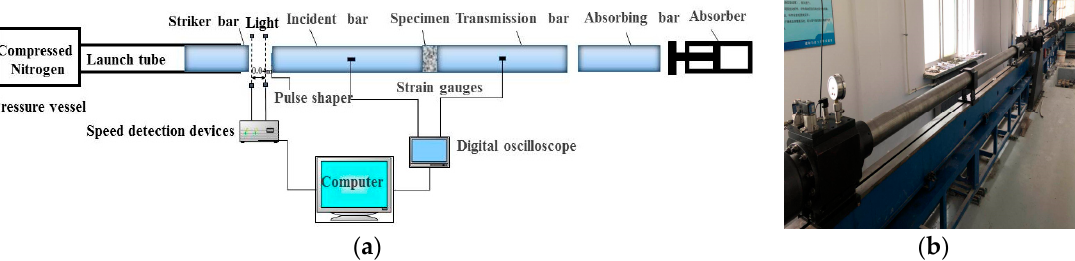
Figure 2. Schematic diagram and image of SHPB testing system: ( a ) Schematic diagram of SHPB testing system; ( b ) Image of SHPB testing apparatus.